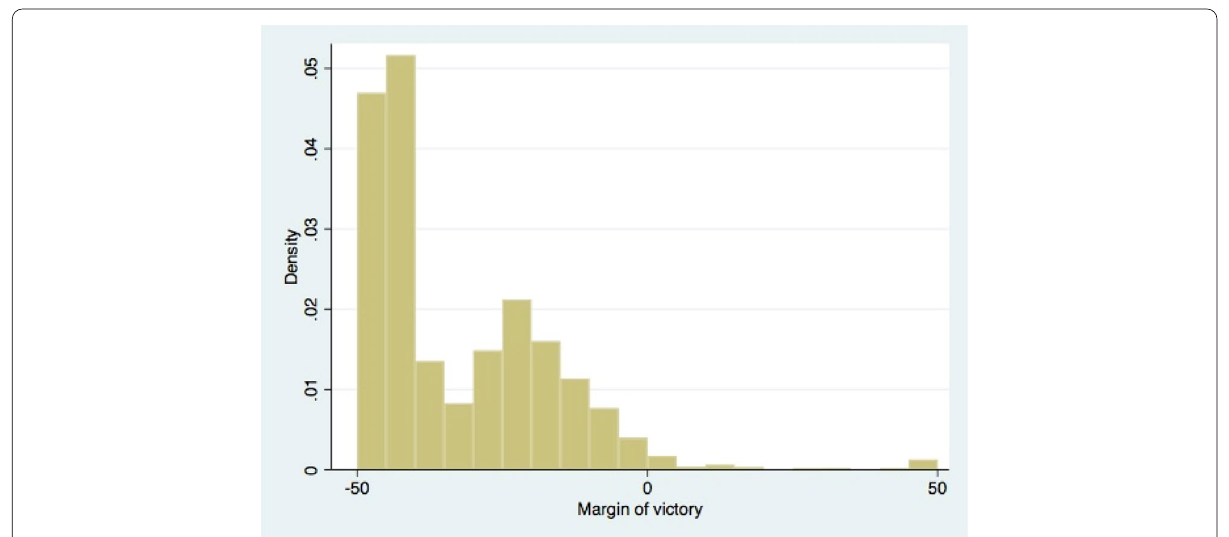
Fig. 1 Distribution for CSR Shareholder